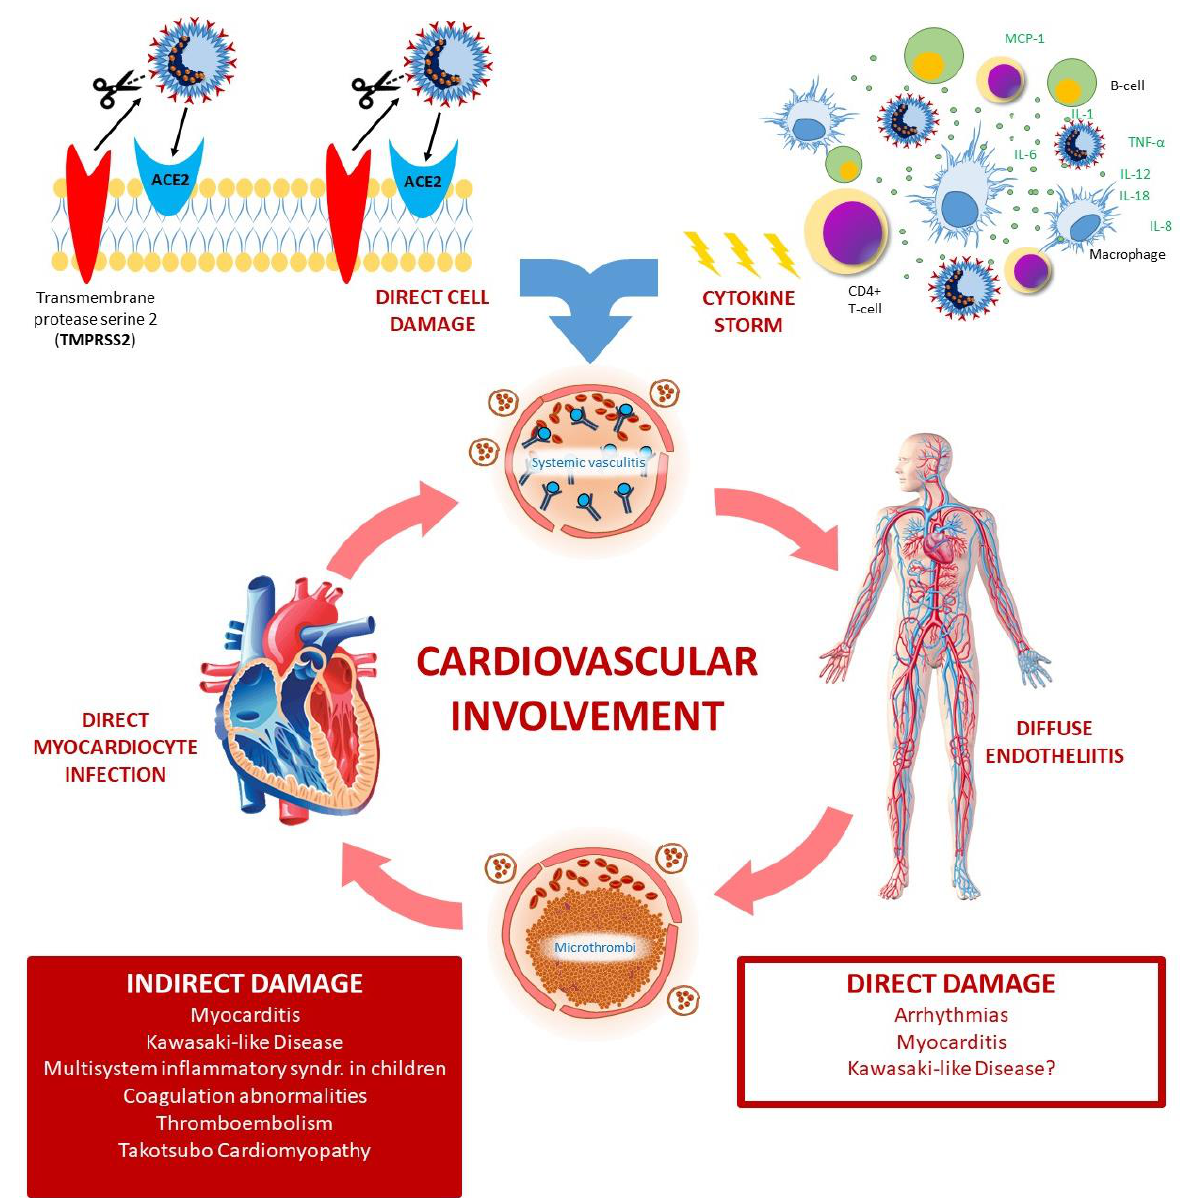
Figure 1. COVID-19 heavily affects patients’ cardiovascular system: it can induce direct damages, leading to arrythmias and myocarditis, and indirect damages, mediated by cytokine storm, systemic vasculitis and vascular thrombosis. The indirect damage contributes to the development of myocarditis and leads to Kawasaki-like Disease and Multisystem inflammatory syndrome, coagulation abnormalities and venous thromboembolism, and Takotsubo cardiomyopathy. ACE2: Angiotensin Converting Enzyme 2; IFN- γ = interferon- γ , MCP1 = monocyte chemoattractant protein 1, MIP1- α = macrophage inflammatory protein 1- α; ROS = Reactive Oxygen Species; TMPRSS2: Transmembrane protease, serine 2; TNF- α = tumour necrosis factor- α.